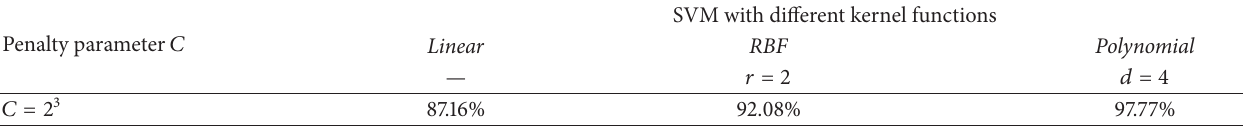
Table 6: Accuracies of SVM under the linear kernel of KPCA and Db4/L4. Penalty parameter 𝐶